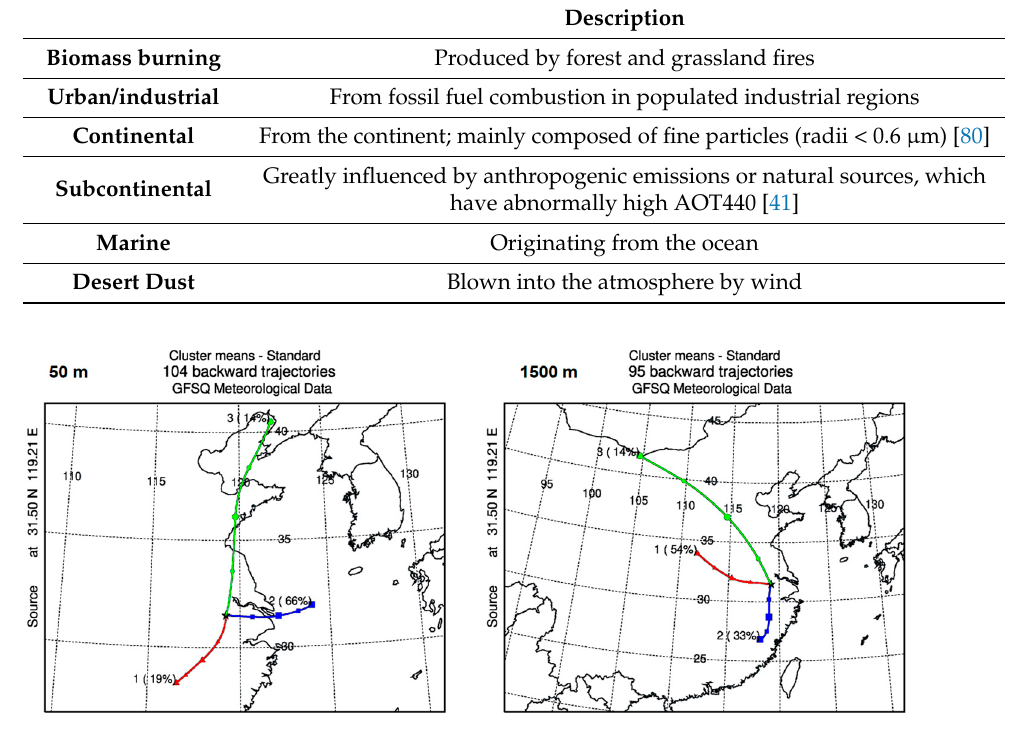
Figure A1. The backward trajectory analysis of April 2019. The black star denotes the Shangxing validation Site .